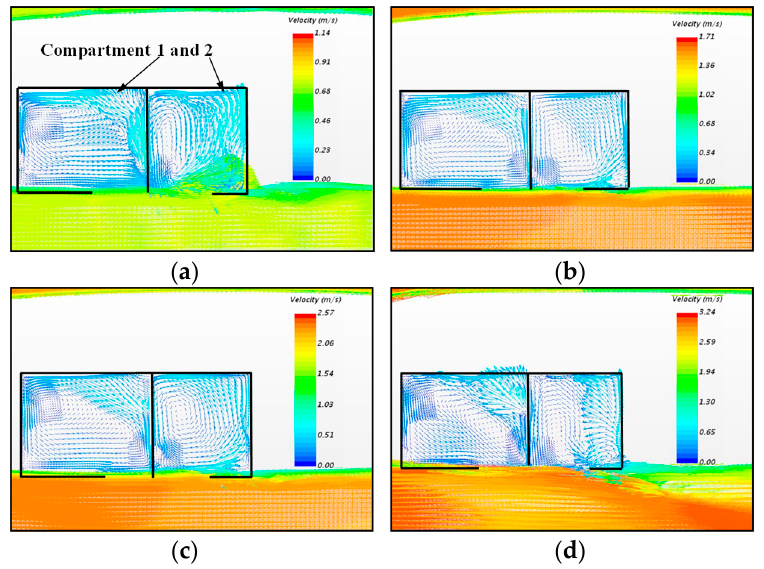
Figure 18. Comparison of local flow for the ship under asymmetric flooding at different forward speeds: ( a ) Fr = 0.1 ( b ) Fr = 0.2 ( c ) Fr = 0.3 ( d ) Fr =